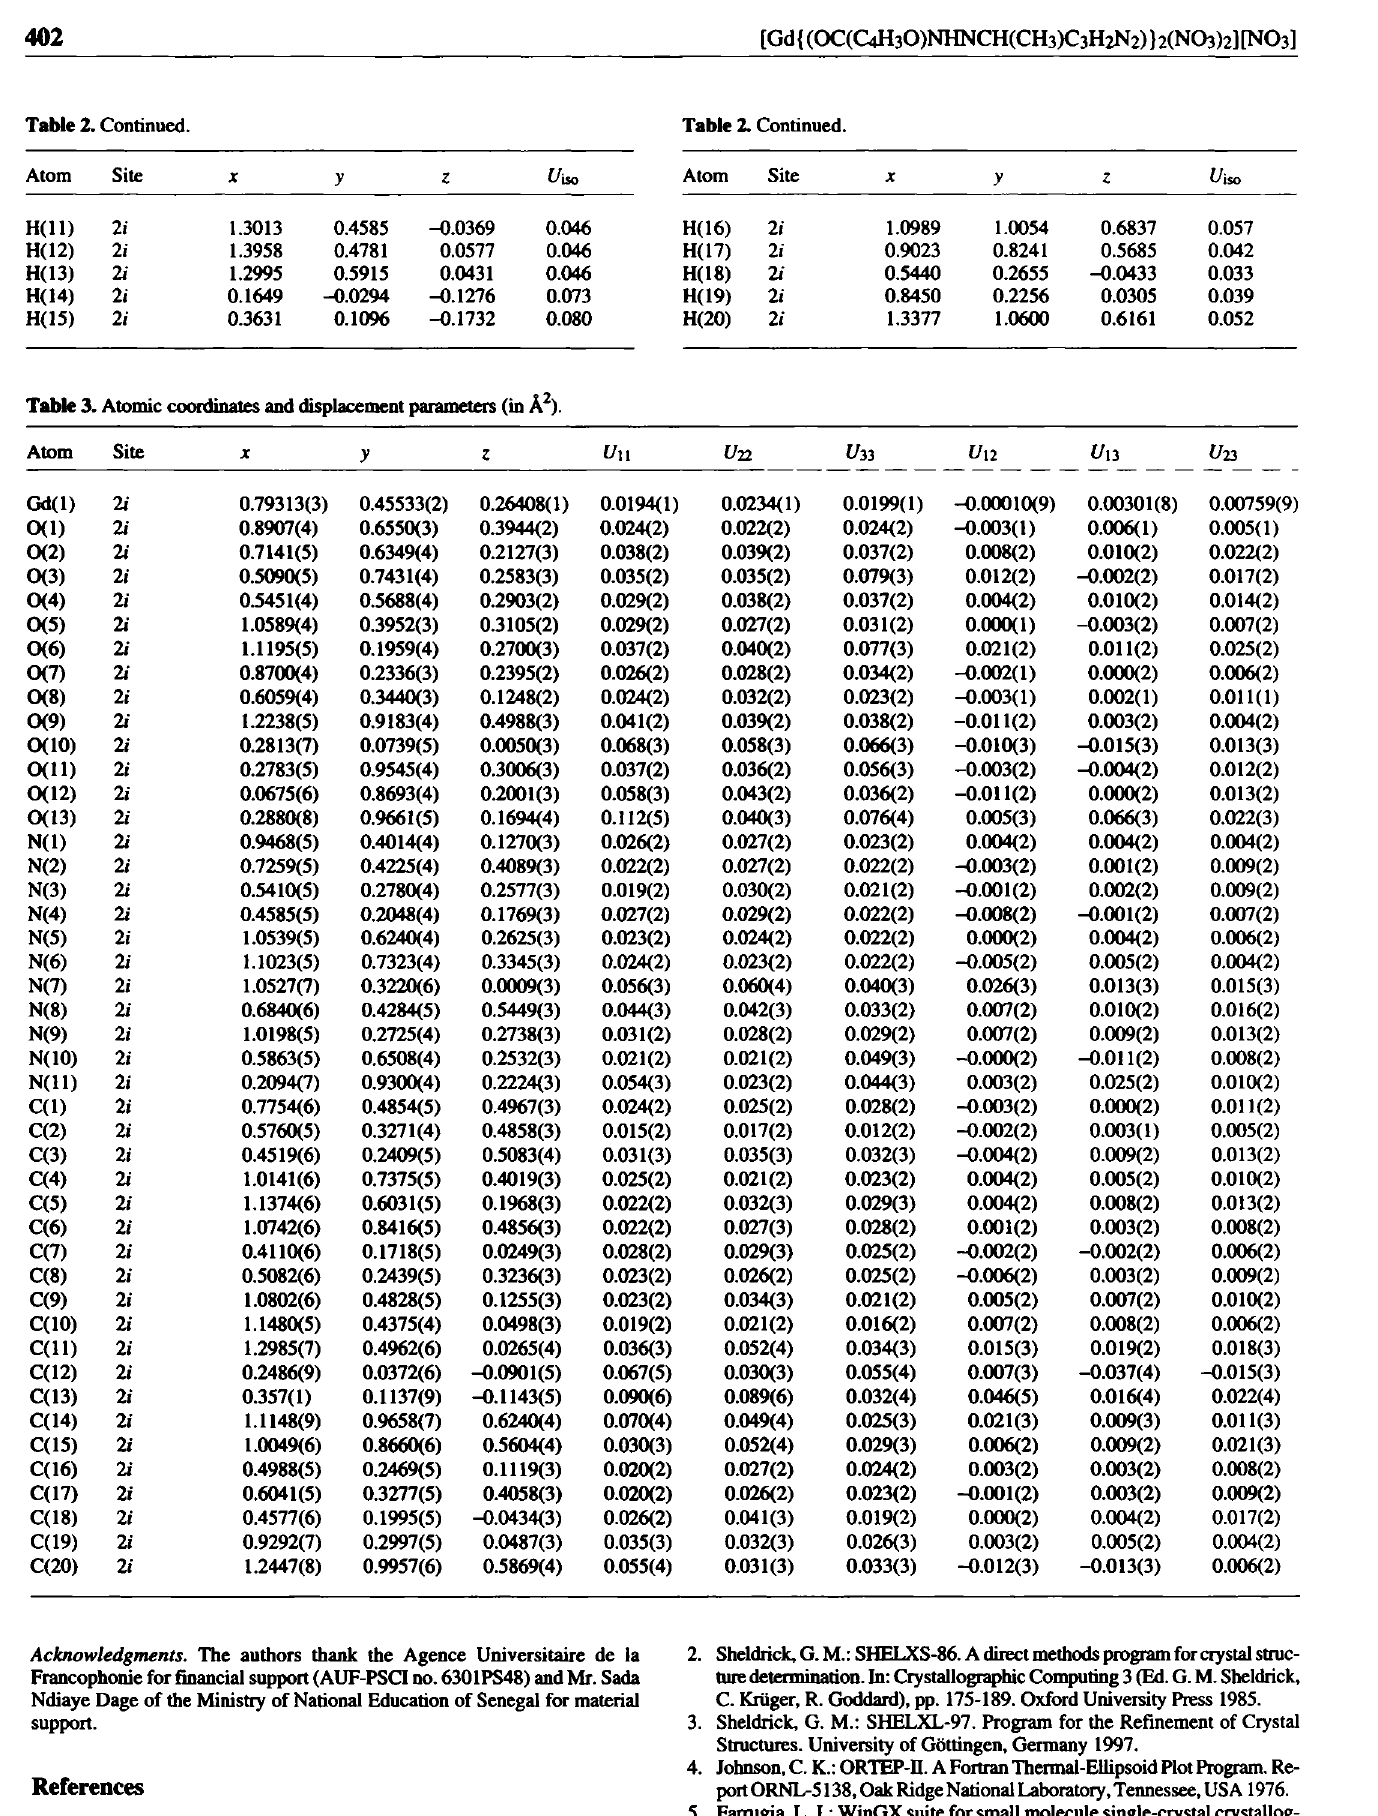
Table 3. Atomic coordinates and displacement parameters (in Ä 2